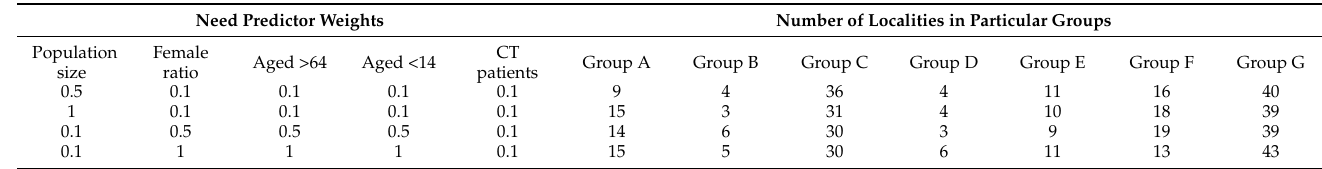
Table 4. Results of the weight sensitivity analysis—number of localities distributed to group A–G in runs of the model based on changed